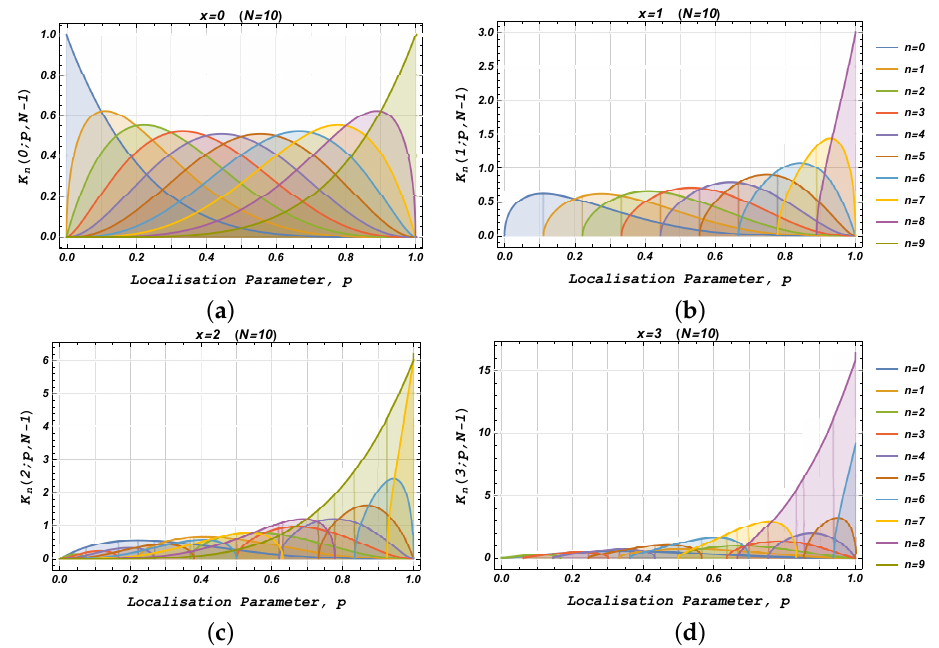
Figure 1. The KPs graphs with respect to the localisation parameter, p , for N = 10 and different values of x : ( a ) x = 0, ( b ) x = 1, ( c ) x = 2, ( d ) x = 3.